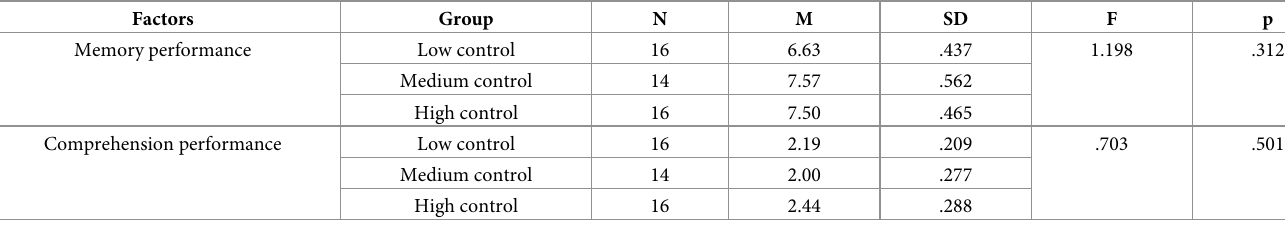
Table 5. Differences of participants’ learning performance among groups.